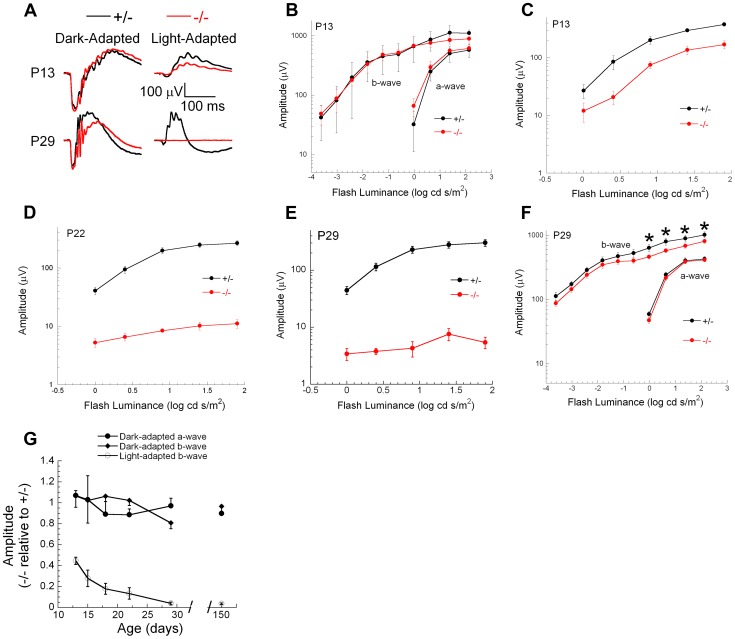
Electrophysiological responses of cones and rod photoreceptors upon ablation of Ranbp2 in cones.(A) Representative electroretinograms (ERGs) of control HRGP-cre:Ranbp2+/− (+/−, black) and HRGP-cre:Ranbp2−/− mice (−/−, red) mice at P13 and P29 to a 1.4 log cd s/m2 stimulus flash presented in darkness (left) or superimposed upon a steady rod-desensitizing adapting field (right). (B–F) Luminance-response functions for the major components of the dark-adapted rod (B, F) or light-adapted cone ERGs (C–E) at P13 (B, C), P22 (D) or P29 (E, F). Repeated measures analysis of variance was used to compare luminance-response functions of +/− and −/− mice for the amplitude of the major ERG components. Cone ERG amplitudes were significantly reduced in −/− mice at all ages examined (P13, P18, P22, P29, P150). Dark-adapted a-wave amplitudes were not different between +/− and −/− mice at any age examined. Dark-adapted b-wave luminance-response functions were also not different between +/− and −/− mice at any age examined. At P29 (F) and P150, dark-adapted ERG b-waves were significantly reduced (p<0.05, t-test, denoted by *) for stimuli above 0.0 log cd s/m2, but not for lower luminance stimuli. (G) Amplitude of −/− responses expressed relative to those of +/− littermates for the major ERG response components. Each measure reflects a single stimulus condition: ‘Light-adapted b-wave’ represents cone ERGs obtained to a 1.4 log cd s/m2 stimulus flash superimposed upon a steady adapting field; ‘Dark-adapted a-wave’ represents rod ERG a-waves obtained to a 1.4 log cd s/m2 stimulus flash presented in darkness; ‘Dark-adapted b-wave’ represents rod ERG b-waves obtained to a −1.2 log cd s/m2 stimulus flash presented in darkness. Data points indicate the average ± s.e.m. for n = 5–10 mice.